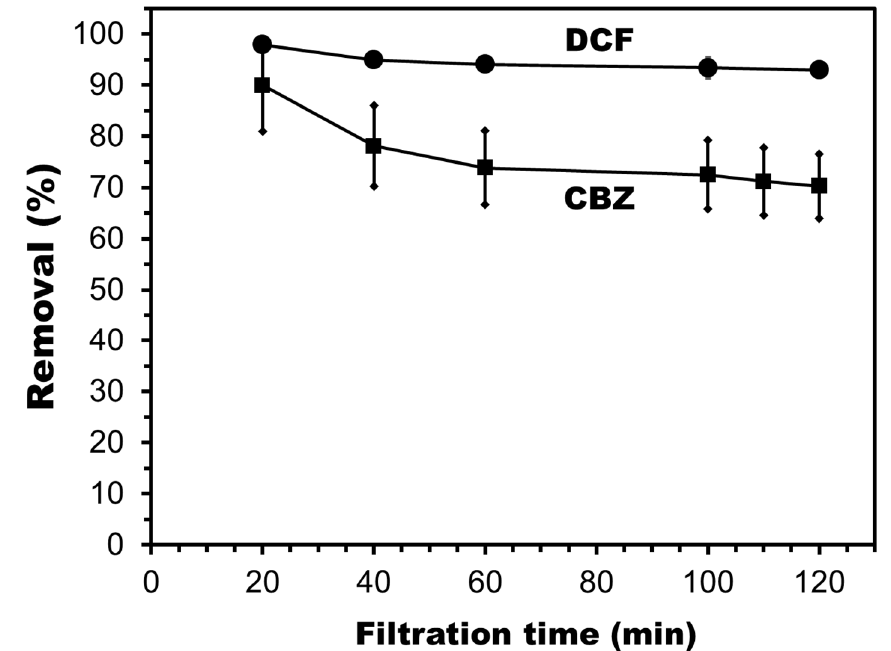
Figure 9. Diclofenac sodium (DCF) and carbamazepine (CBZ) removal over time by the UiO-66_GO / NF-10% membrane (experimental conditions: initial DCF and CBZ concentration = 1 mg / L; operation pressure = 4 bar; solution pH = 5). Plots and error bars represent averages and standard deviations from duplicate experiments.